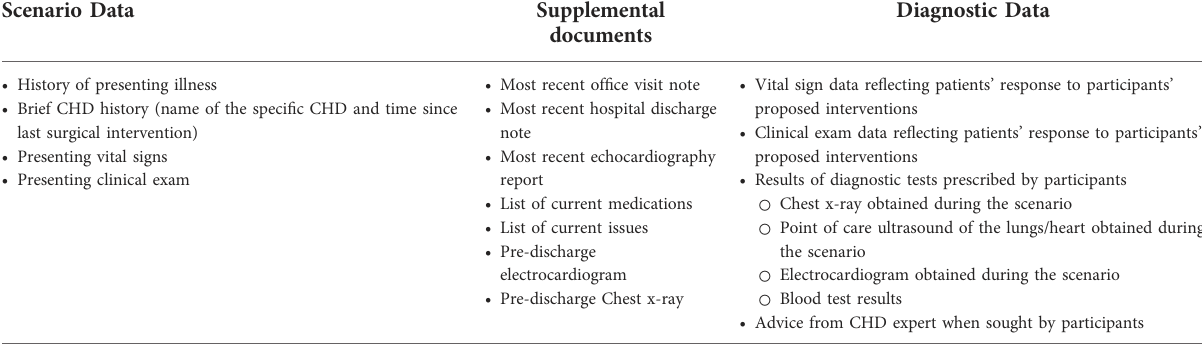
TABLE 1 List of available data, documents, and diagnostic results made available to participants. Scenario